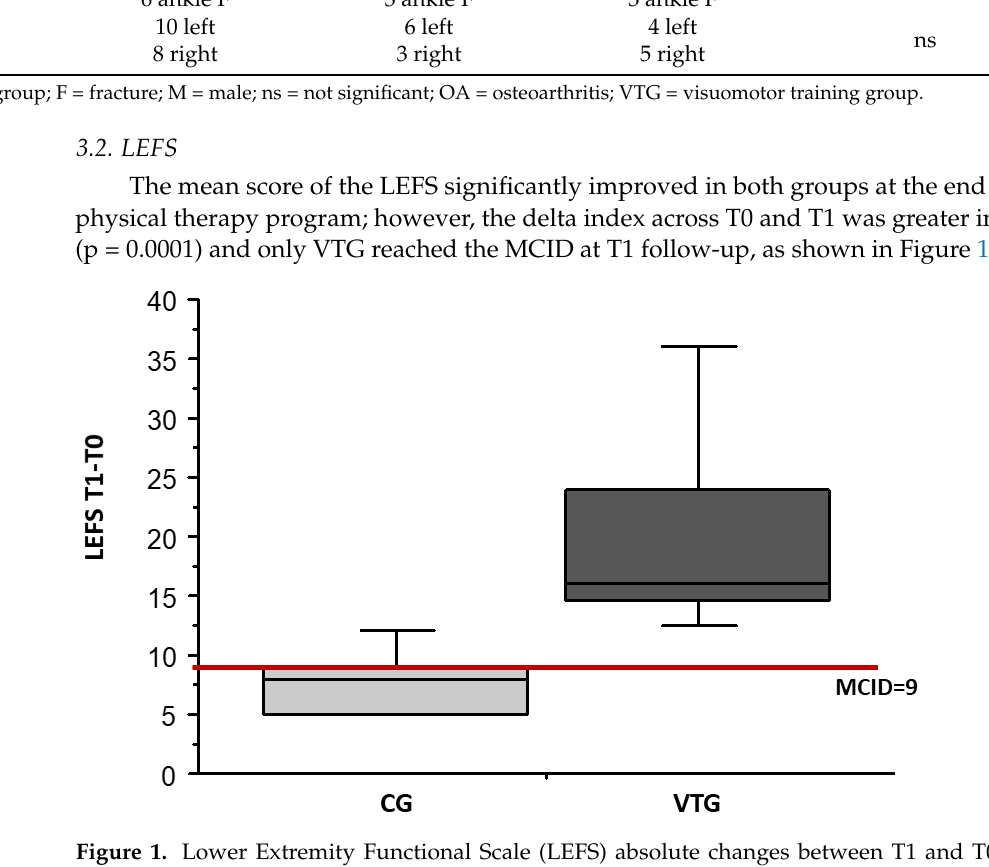
Figure 1. Lower Extremity Functional Scale (LEFS) absolute changes between T1 and T0. The horizontal line represents the LEFS minimum clinically important difference (MCID) that is 9 points. CG = control group; VTG = visuomotor training group.